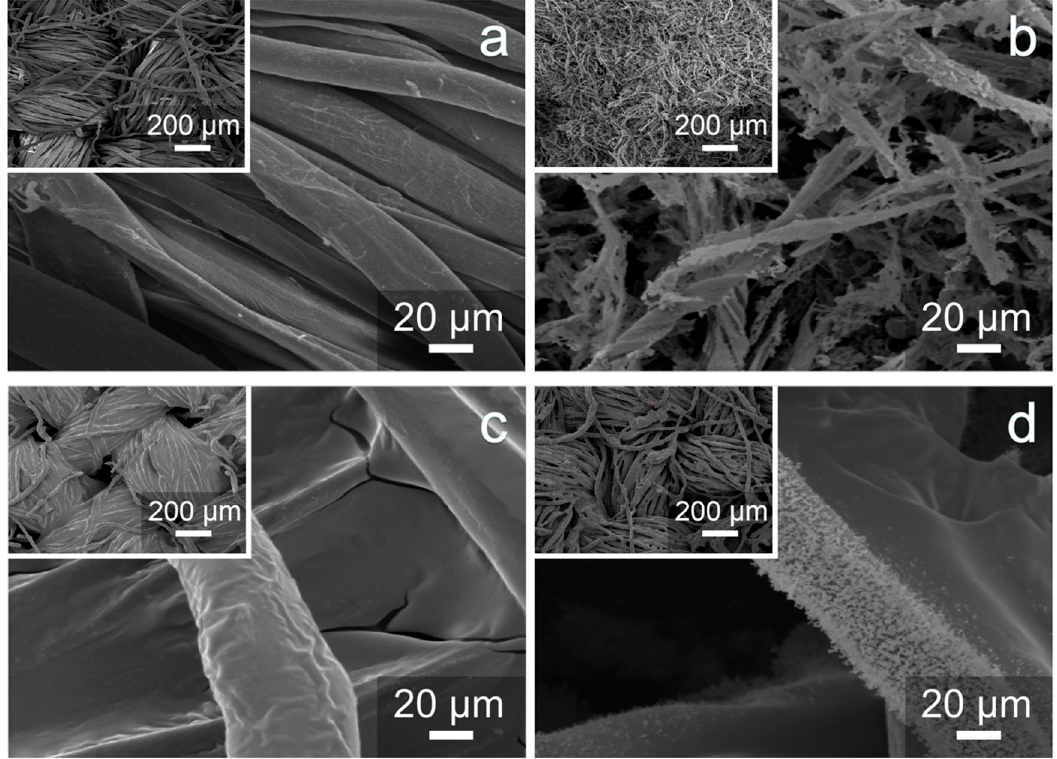
Figure 6. SEM images of pristine cotton fabrics ( a ), pristine cotton fabrics after combustion ( b ), treated cotton fabrics ( c ), treated cotton fabrics after combustion ( d ) at different